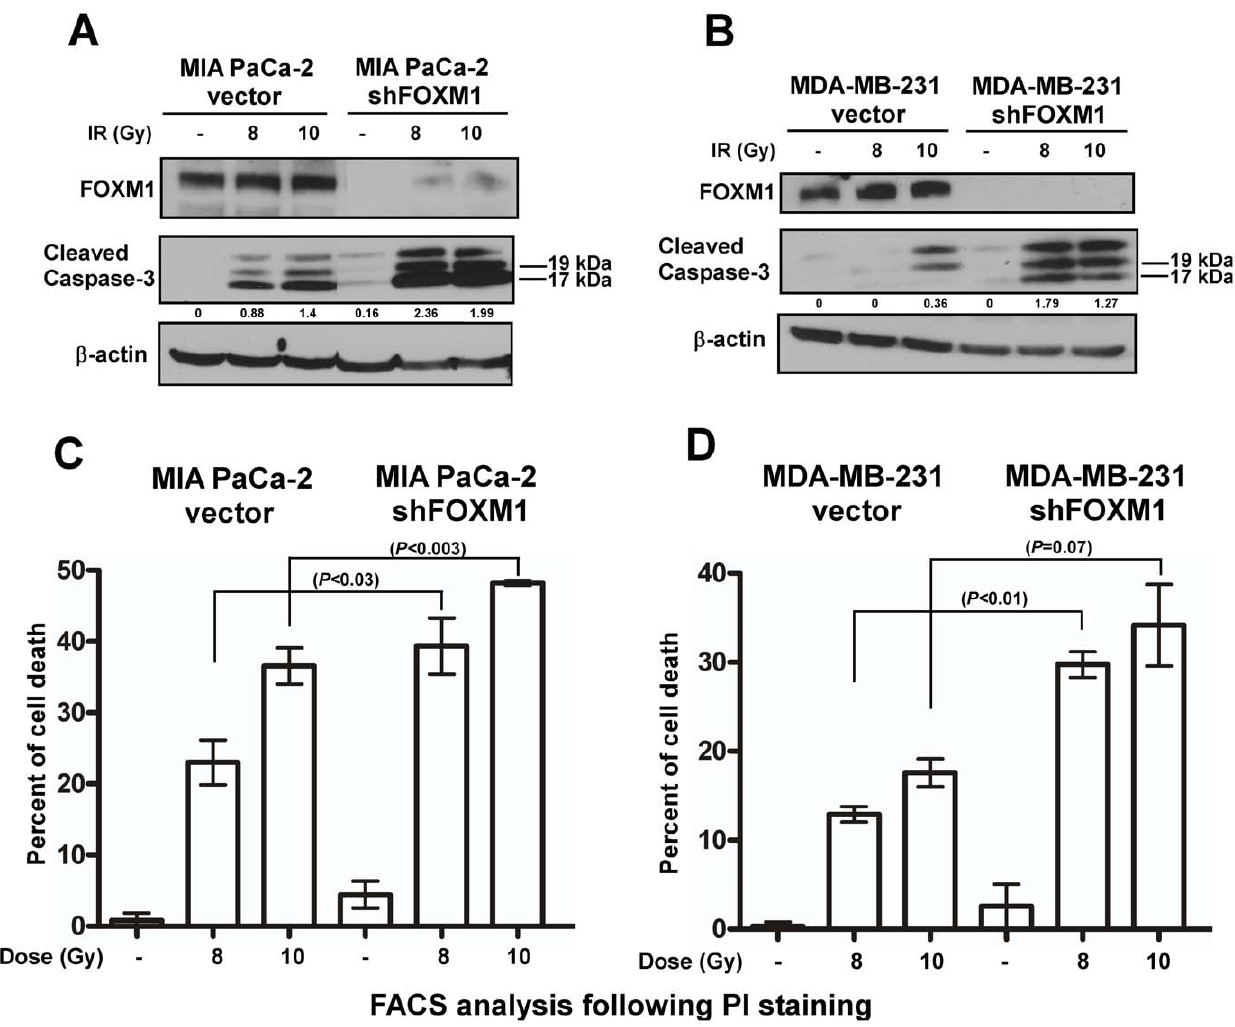
Figure 2. Suppression of FOXM1 by RNAi sensitizes human cancer cells to irradiation. ( A ) MIA PaCa-2 control and FOXM1 knockdown pancreatic cancer cells were c -irradiated with 8 and 10 Gy. Seventy-two hours after irradiation cells were harvested and immunoblotting was carried out with antibodies for FOXM1 and cleaved caspase-3. b -actin was used as the loading control. ( B ) MDA-MB-231 control and FOXM1 knockdown breast cancer cells were subjected to c -irradiation with the indicated doses. Forty-eight hours following irradiation cells were harvested and immunoblotting was performed for FOXM1, cleaved caspase-3 and b -actin as the loading control. ( C–D ) Degree of cell death was assessed by flow cytometry following propidium iodide staining in MIA PaCa-2 pancreatic and MDA-MB-231 breast control and FOXM1 knockdown cancer cells, respectively, 48 hours after c -irradiation. Graph shows quantification as a percentage of apoptotic cells compared to the vector control nontreated cells, 6 SD of a representative triplicate ( C ) or duplicate ( D )